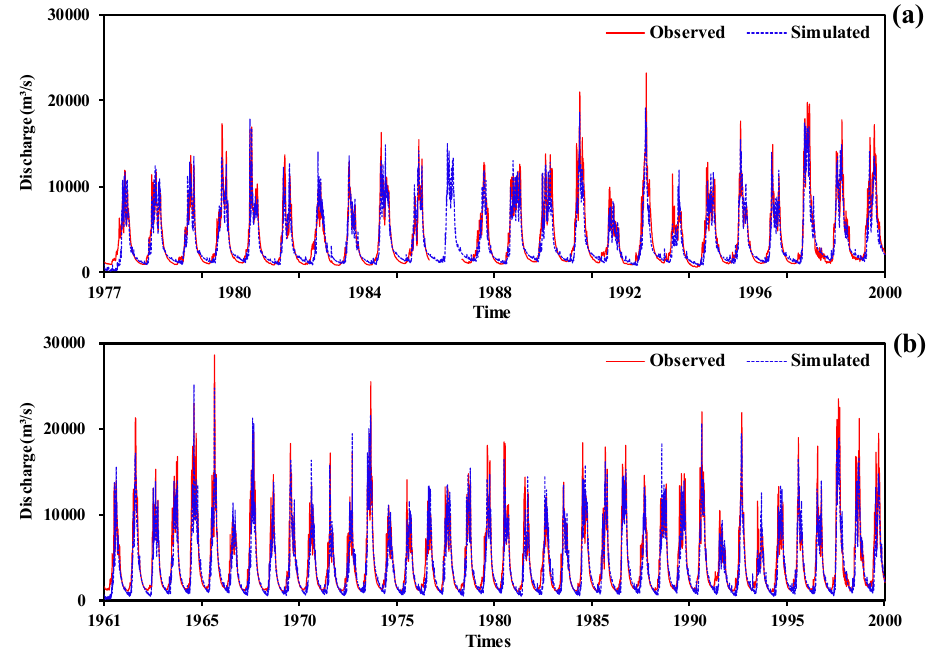
Figure 4. Observed and simulated daily discharge: ( a ) the Huatan station; ( b ) the Pinghshan station. Table 4. Performance of the XAJ model for daily discharge simulation in Huatan and Pingshan. Station Period